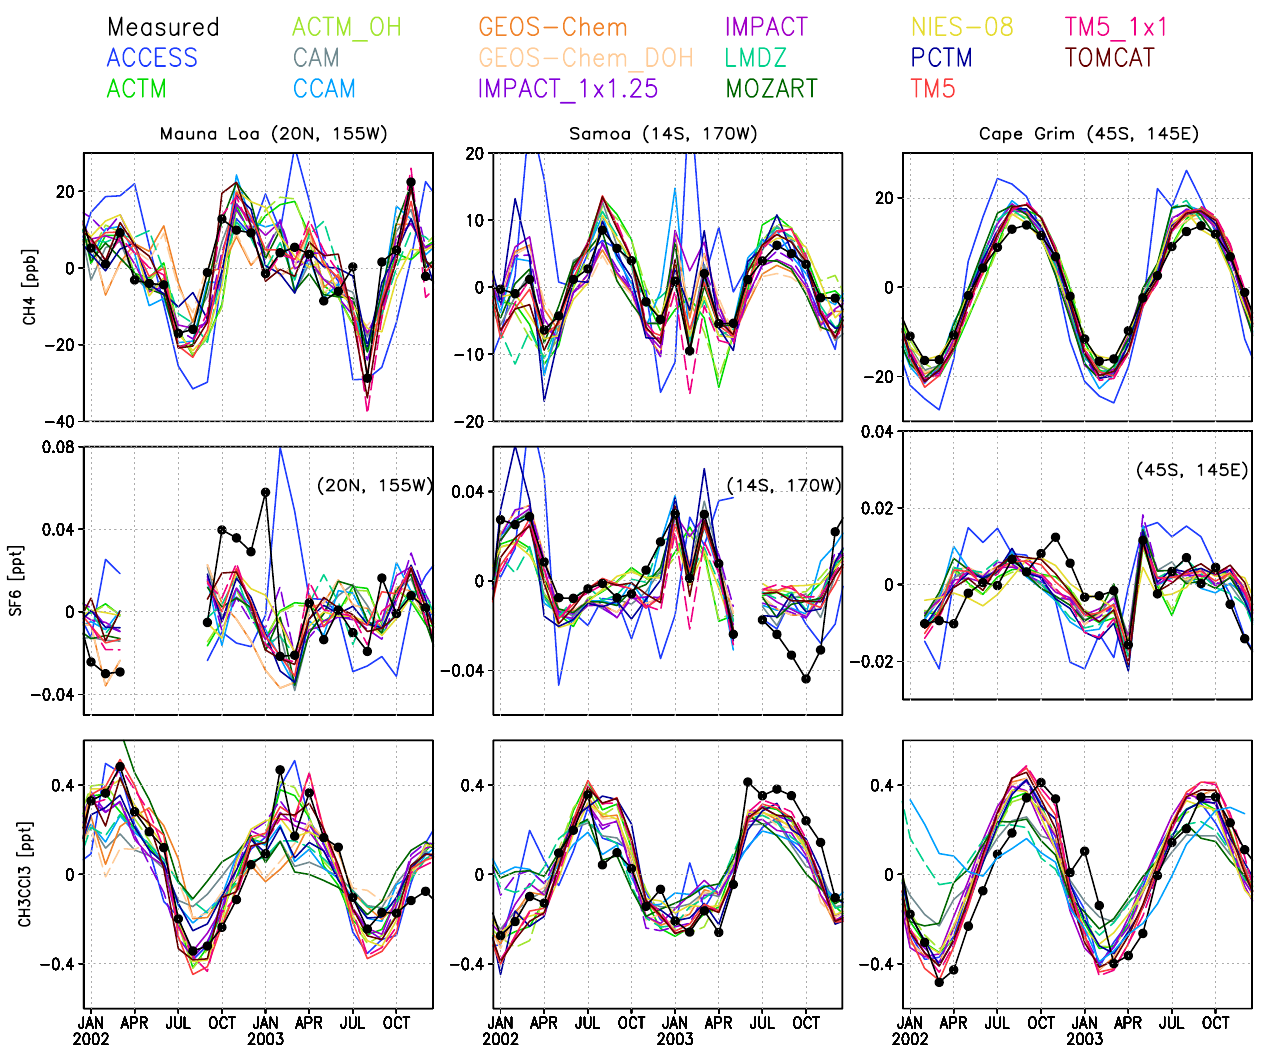
Fig. 5. Comparisons of observed and simulated seasonal cycles of CH 4 in CH 4 CTL scenario (top row), SF 6 (middle row) and CH 3 CCl 3 (bottom row) at 3 selected sites, MLO (left panel), SMO (middle panel) and CGO (right